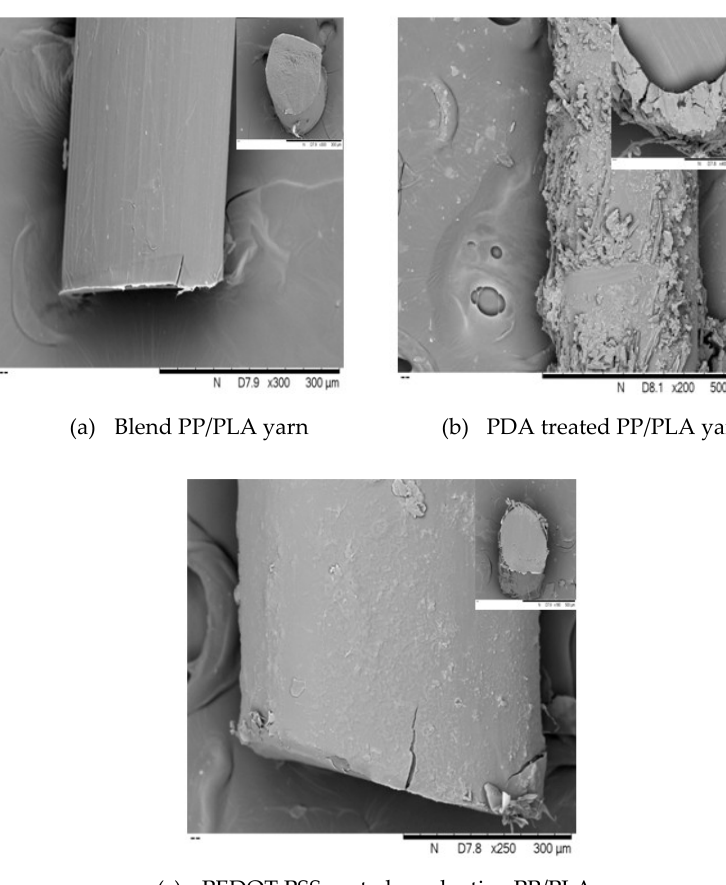
Figure 10. SEM images (surface and cross-section) of PLA yarn at various stages.